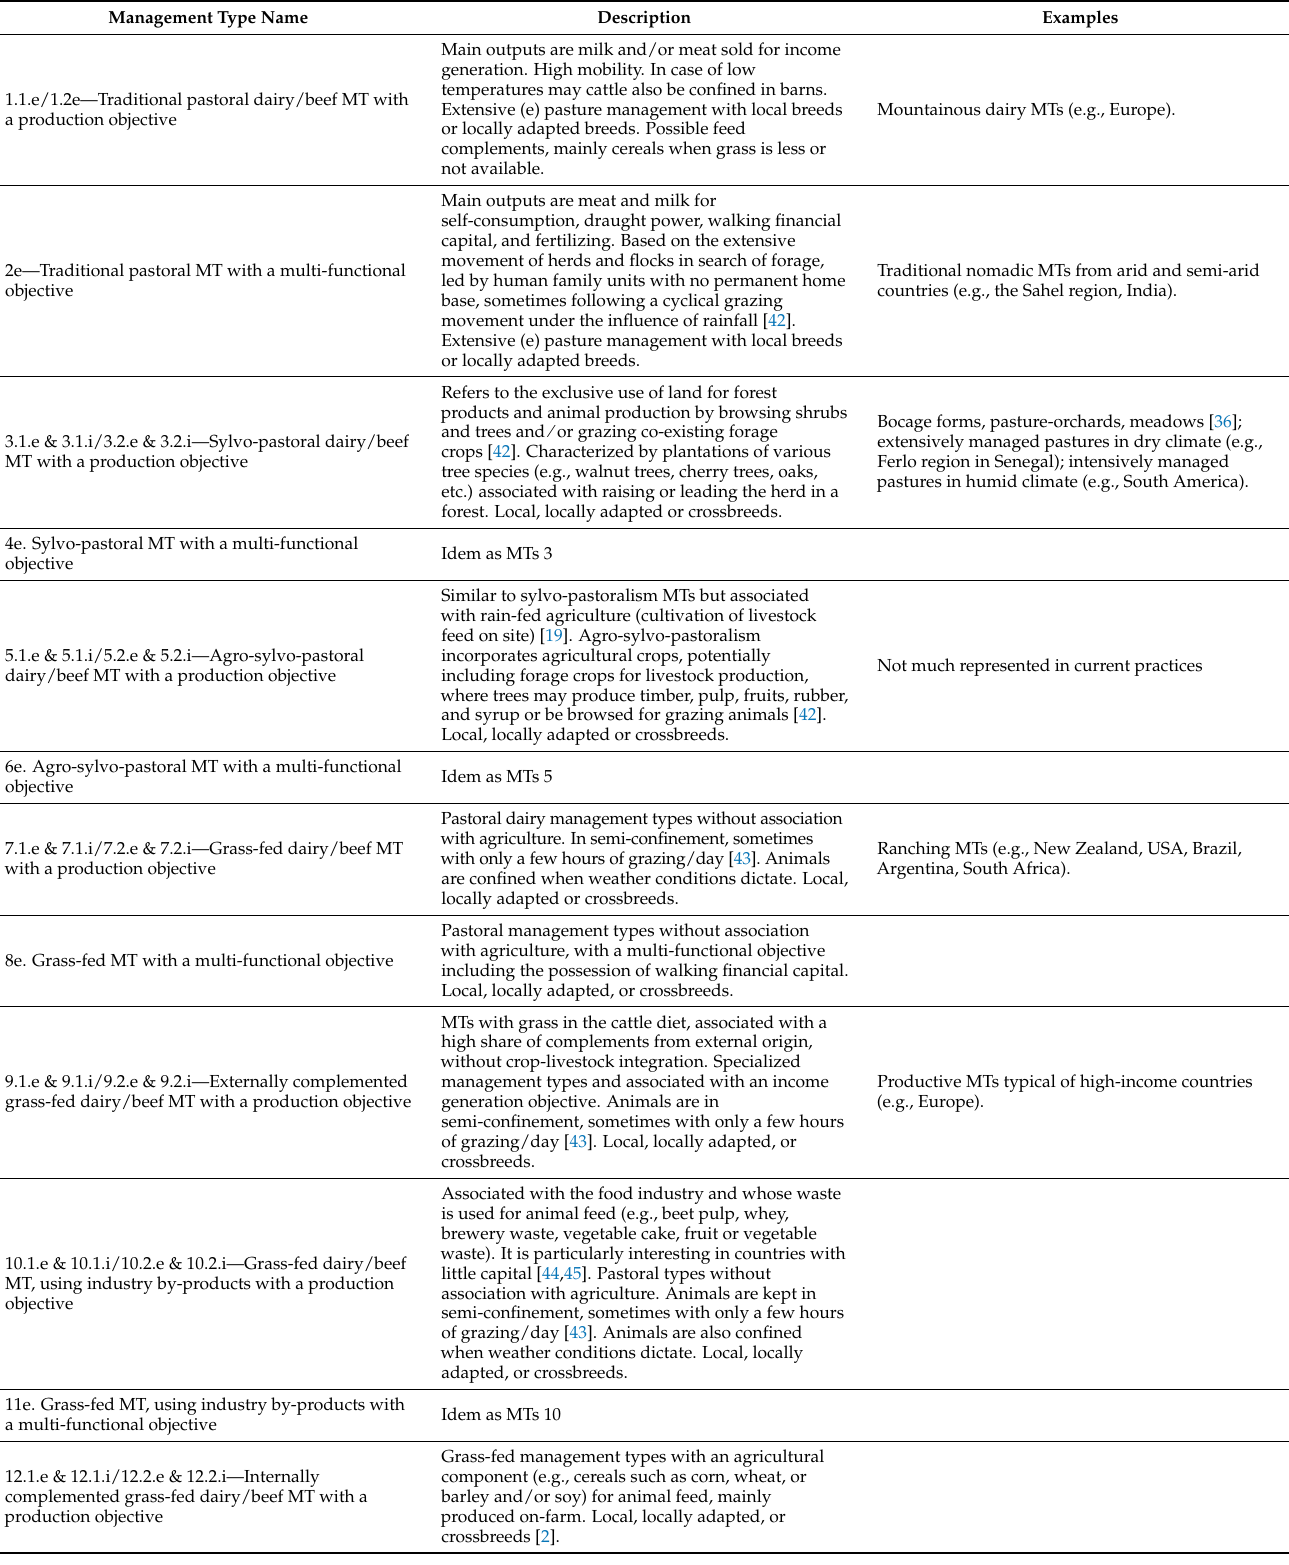
Table A1. MT typology classification (e: extensive pasture management, i: intensive pasture